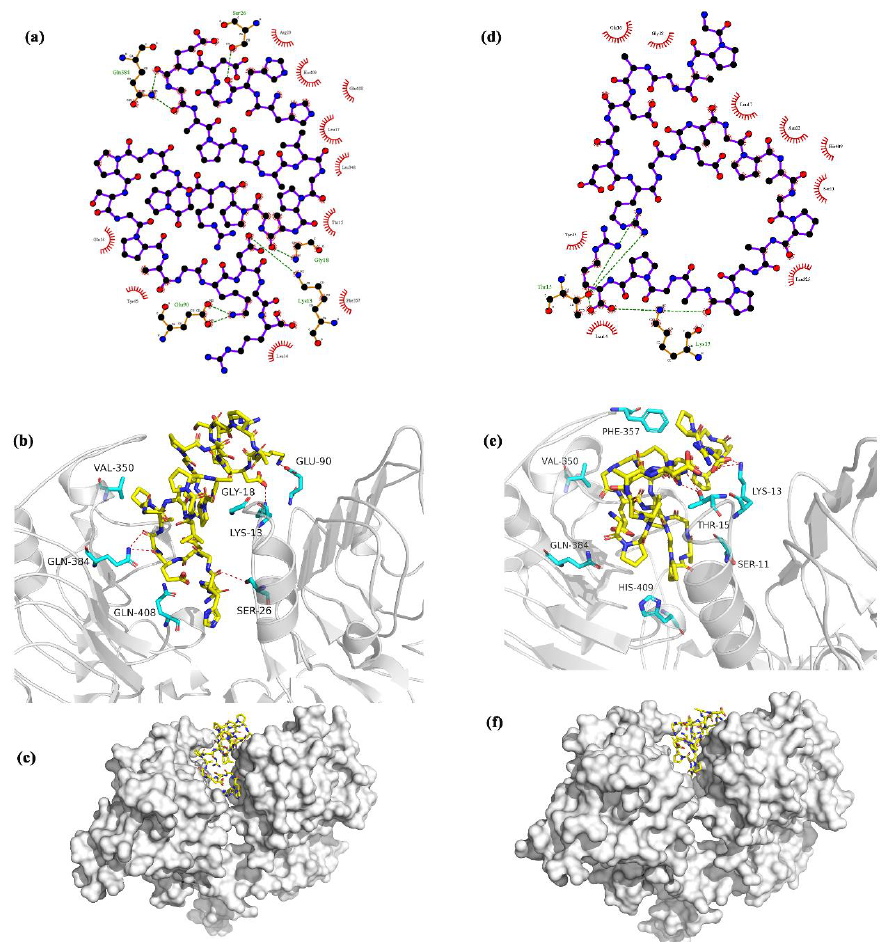
Figure 5. Molecular docking analysis between epidermal growth factor receptor (EGFR) (PDB: 1lVO) and Pep HHG and Pep GPA. ( a ) The 2D view of the Pep HHG binding model with EGFR. The peptide is shown in ball-stick mode in the middle of the figure. The green dotted lines depict the hydrogen bond with the EGFR amino acid sidechain. The red semicircle line represents the hydrophobic interaction between EGFR amino acid residues and the ligand peptide. ( b ) The 3D view of the peptide HHG binding model with the target. The carbon atoms of the ligand are in yellow, and the surrounding binding pocket residues are cyan. The receptor backbone is depicted as a light gray ribbon. The red dotted line shows the hydrogen bond between the ligand and receptor. ( c ) The surface overview of the peptide HHG binding model of the target. The carbon atoms of the ligand are in yellow, and the receptor surface is white. ( d ) The 2D view of the Pep GPA binding model with EGFR. The peptide is shown in ball-stick mode in the middle of the figure. The green dotted lines depict the hydrogen bond with the EGFR amino acid sidechain. The red semicircle line represents the hydrophobic interaction between EGFR amino acid residues and the ligand peptide. ( e ) The 3D view of peptide GPA binding model with EGFR. The carbon atoms of the ligand are in yellow, and the surrounding binding pocket residues are cyan. The receptor backbone is depicted as a light gray ribbon. The red dotted line shows the hydrogen bond between the ligand and receptor. ( f ) The surface overview of the peptide GPA and EGFR binding model. The carbon atoms of the ligand are in yellow, and the receptor surface is white. Pep HHG: peptide HHGDQGAPGAVGPAGPRGPAGPSGPAGKDGR (Deamidation); Pep GPA: peptide GPAGANGDRGEAGPAGPAGPAGPR